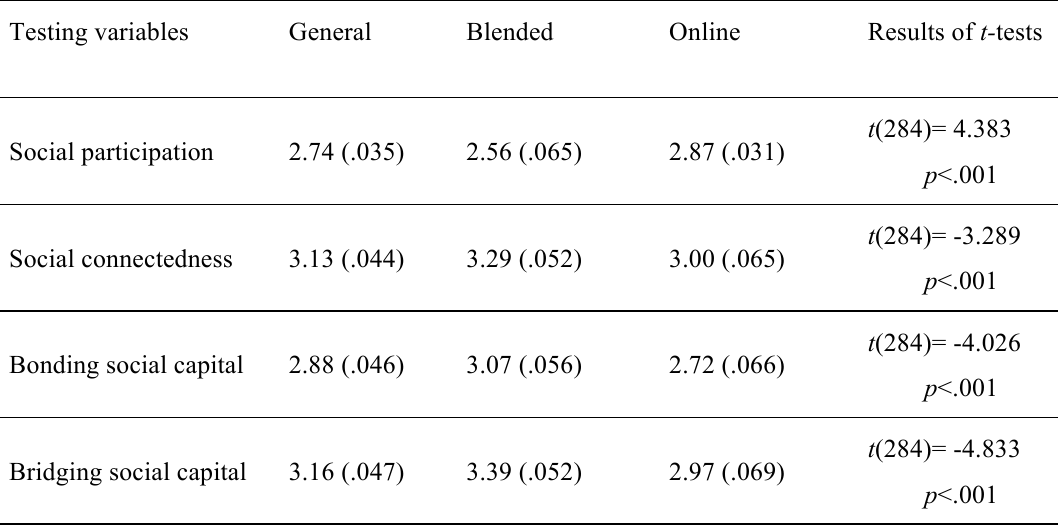
Table 4 : Descriptive statistics of social inclusion and social capital among AEC blended and FEA online adult learners M(SE )